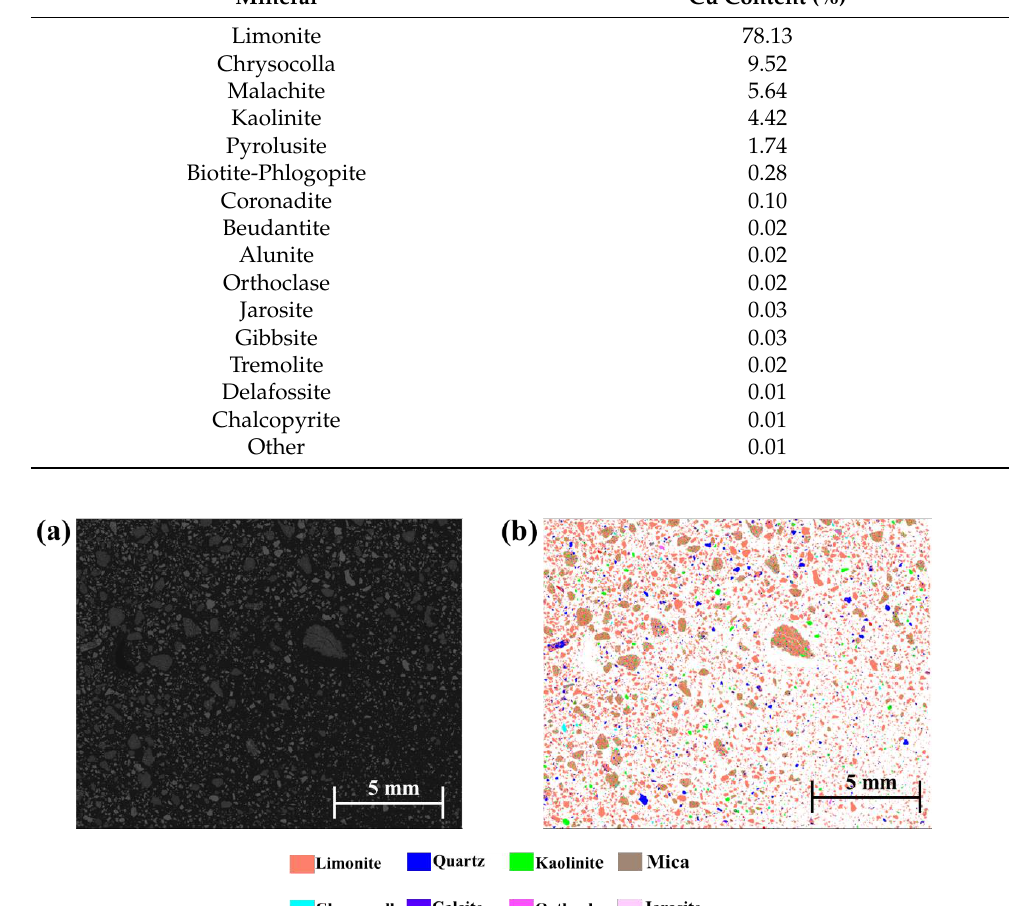
Minerals 2022 , 12 , x FOR PEER REVIEW Figure 3. Minerals intercalation relationship images from MLA analysis: ( a ) original image; ( b ) color image.